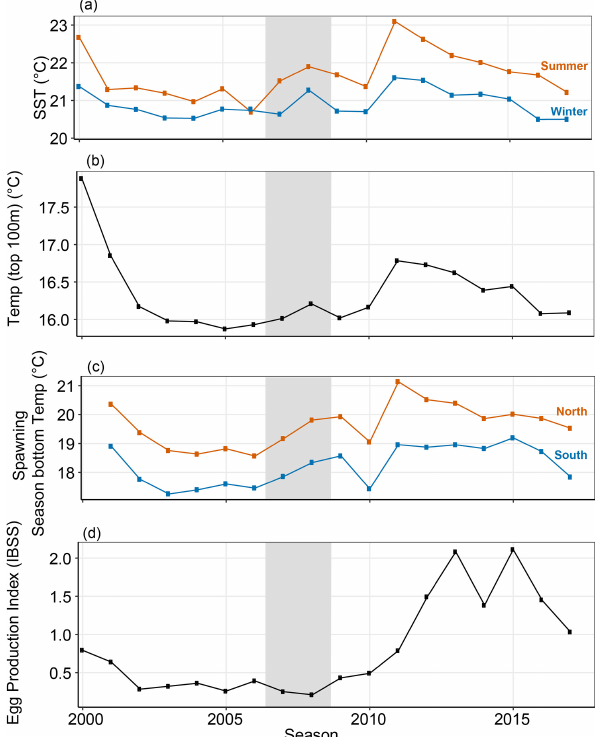
Figure 5. Parameters calculated for seasonal analysis of PI. (a) Sea surface temperature ( ◦ C) from 24–34 ◦ S and out to 108 ◦ E obtained from the SSTAARS daily dataset on the IMOS AODN portal from 1996 to 2016. (b) Temperature in the top 100m of the offshore area from 24–34 ◦ S and east of 108 ◦ E over January–December, the av- erage time phyllosoma are offshore. (c) Average bottom tempera- ture (40–80m depths) ( ◦ C) of the spawning season for associated PI season for October to March in the northern (blue line, shown in Fig. 2a) and southern latitudes (red line, shown in Fig. 2a) of the fishery. (d) The independent breeding stock survey index (IBSS) lagged 1 year to give a spawning stock index for the year prior (de Lestang et al., 2016). Grey shaded seasons (2008 and 2009) indicate the less-than-expected PI based on a priori relationships (Caputi et al.,